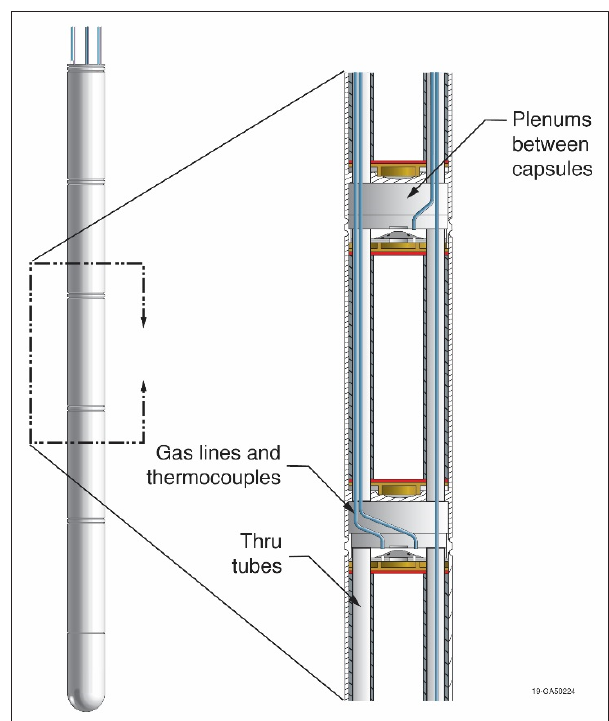
Fig. 1. Elevation view of typical AGR fuel experiment.